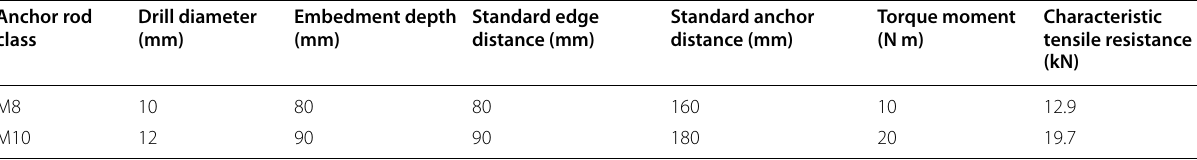
Table 4 Mechanical properties of chemical adhesive.